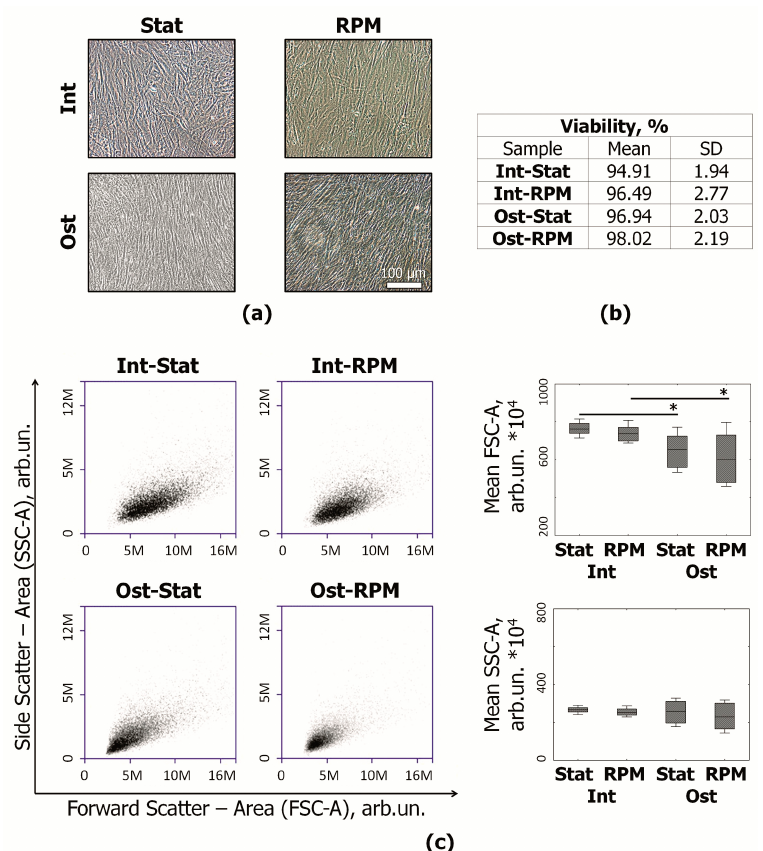
Figure 3. Morphology and viability of MSCs after 10 days of RPM exposure: ( a ) representative images of MSCs, light microscopy (phase contrast); ( b ) the share of viable MSCs; ( c ) evaluation of MSC size/granularity. Representative flow cytometry plots of FSC-A/SSC-A (size/granularity, respectively) distribution and boxplots. Data are presented as median, Q1/Q3, min/max; n ≥ 10, * p < 0.05. MSCs—mesenchymal stromal cells; Int—intact MSCs; Ost—osteocommitted MSCs; Stat—static control; RPM—random positioning machine; FSC-A—forward scatter area; SSC-A—side scatter area.